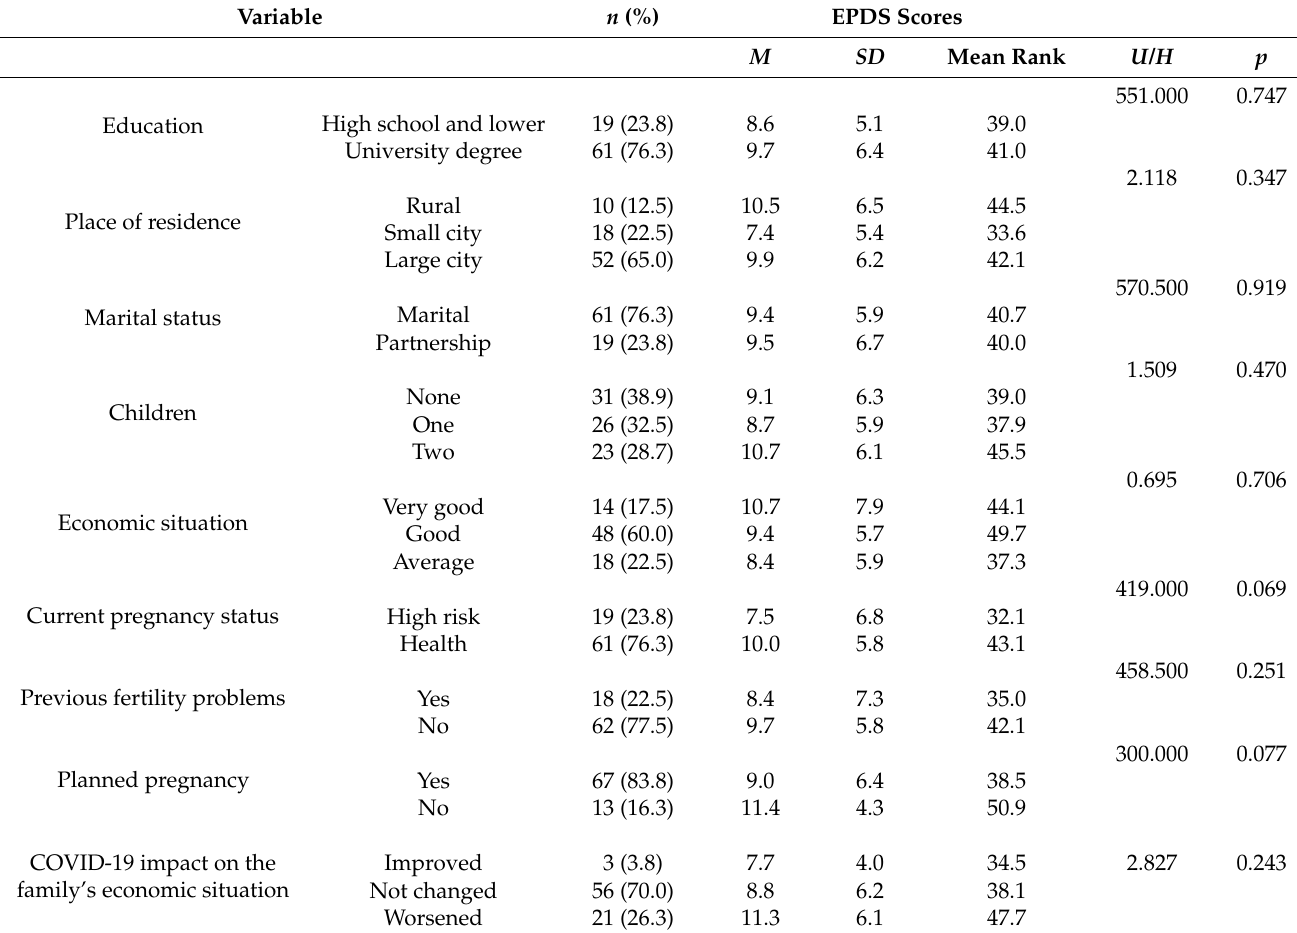
Table 1. Study sample characteristics with regard to prenatal depression scores ( N =